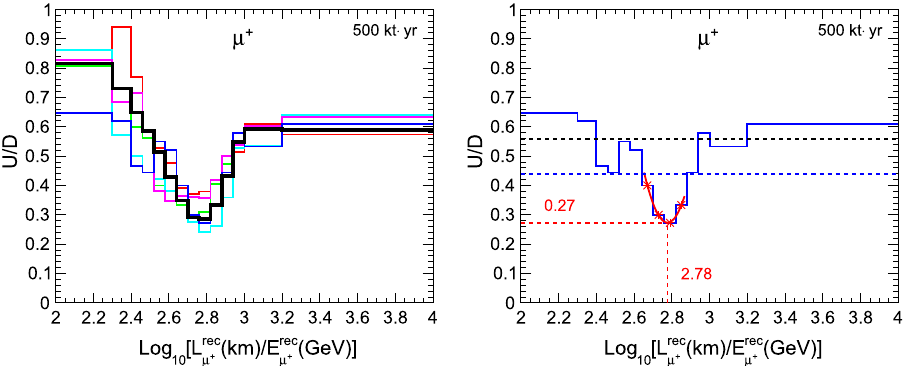
Fig. 5 Left panel: the U/D ratios as functions of log 10 [ L rec μ / E rec μ ] for five independent simulated data sets with 500 kt · yr exposure of ICAL are shown by thin colored lines. The black solid line is the mean of 100 such data sets. Right panel: the red parabola represents the fit to the dip